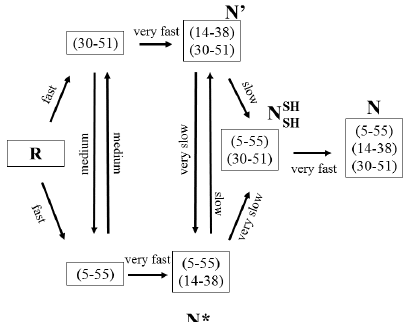
Figure 2. The oxidative folding pathway of BPTI. The fully reduced protein rapidly forms two one-disulfide-bond-containing species, viz. (30–51) and (5–55), both of which are native bonds. Both species are very rapidly oxidized to form two structured, albeit kinetically trapped, 2S* intermediates. Each species undergoes intramolecular disulfide rearrangement to form des (14–38) which is rapidly oxidized to form the native protein. N* and N’ are two-disulfide-bond-containing, kinetically-trapped, intermediates with native-like structure. N is the native protein which contains three native disulfide bonds with the connectivities as shown.